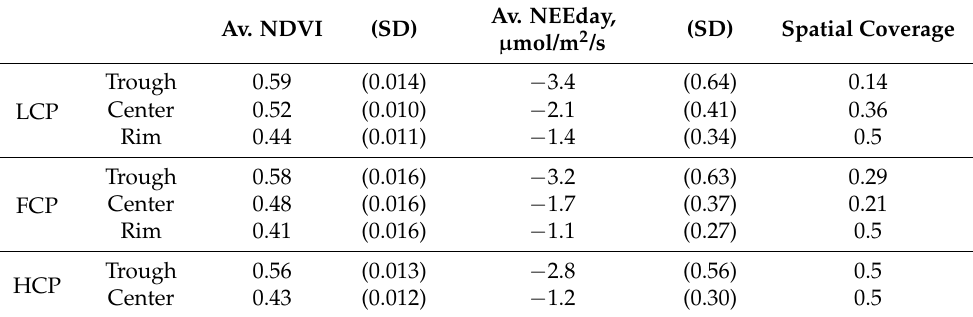
Table 1. Spatial average of NEEday and NDVI temporal average (Av.) over the growing season in each polygon type-feature combination. The standard deviation (SD) is also shown. The spatial coverage is the area of each polygon feature within each polygon type (The total area is normalized to 1). Av. NEEday, (SD) Av. NDVI (SD) µ mol/m 2 /s